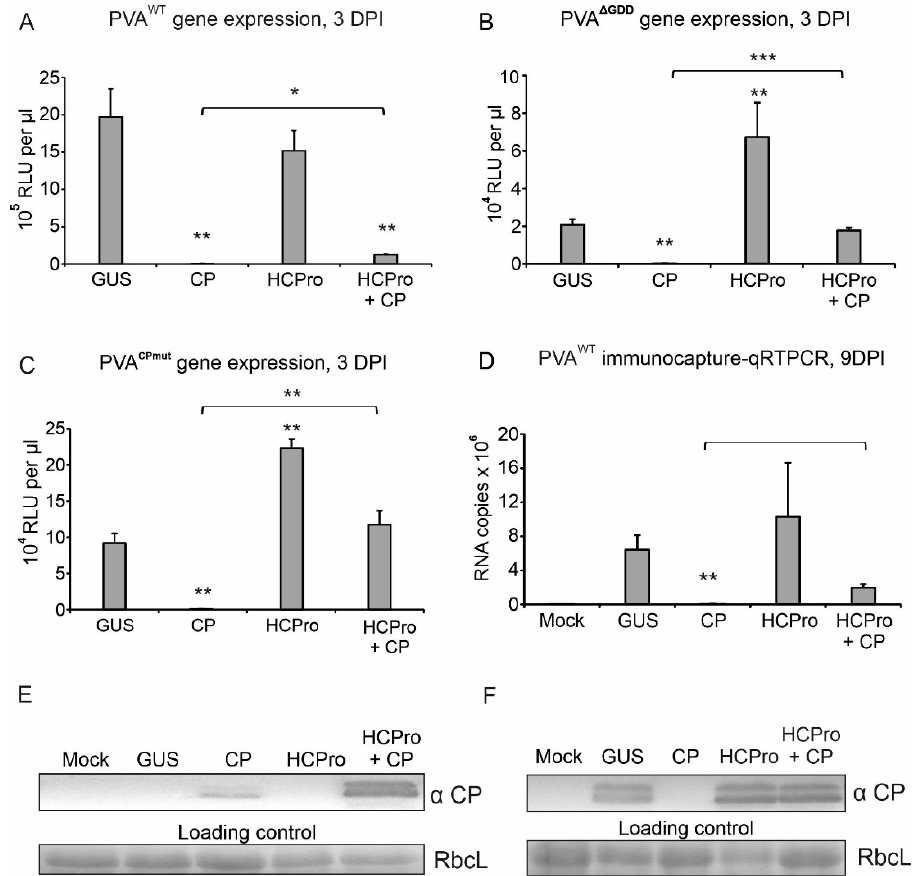
Figure 5. HCPro relieves the CP-mediated translational block of PVA. ( A ) PVA WT was co-expressed with GUS, CP or HCPro alone or with CP and HCPro together. RLUC and CP levels were analyzed at 3 dpi. ( B ) Same as ( A ) but with the PVA Δ GDD . ( C ) Same as ( A ) but with PVA CPmut . ( D ) PVA WT RNA amount from virions was measured by IC-RT-qPCR at 9 dpi in the same setup as in ( A ) p < 0.05 = *; p < 0.01 = **; p < 0.001 = ***. ( E , F ) Western blots showing CP expression in ( A , D ), respectively. CP accumulation in the above-described experiments was assessed by western